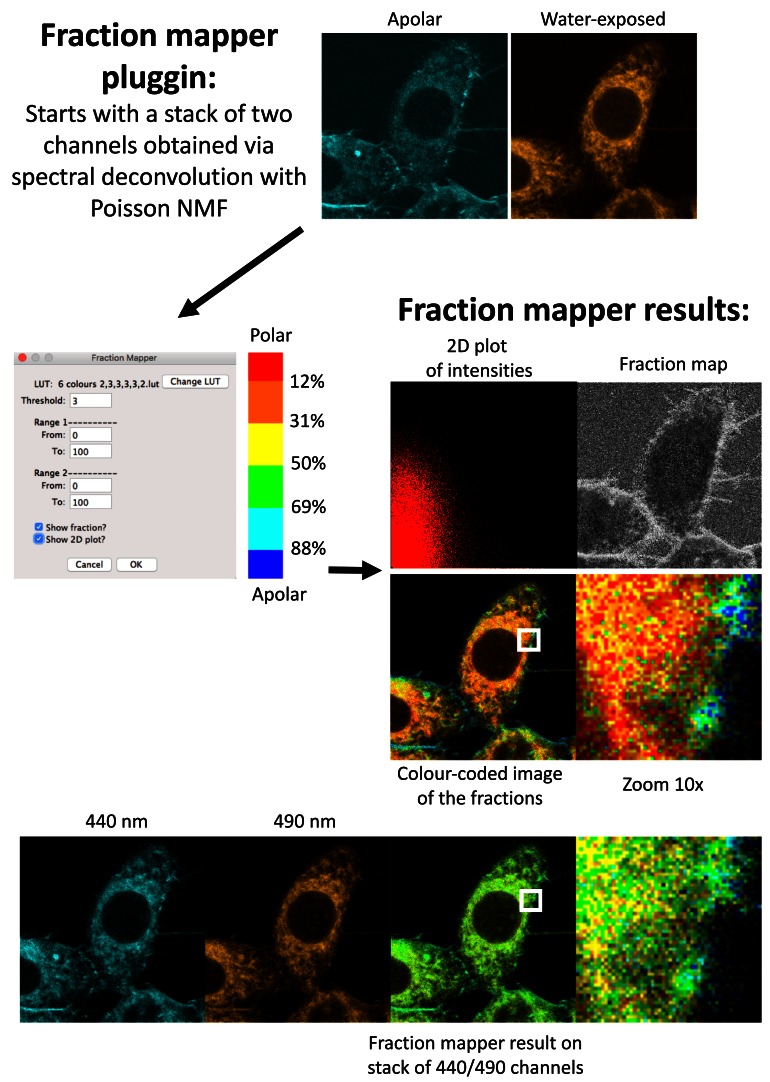
The Fraction Mapper plugin.Starting from a stack of two channels, Fraction Mapper calculates the fraction of the intensity in the first channel for every pixel (ch1/ch1+ch2), which can be obtained as a fraction map. A 2D plot of the intensities in each of the channels can also be generated. The plugin then colour-codes the numbers corresponding to the fraction according to a chosen LUT, and gives the pixels the light intensity of the sum of the two channels. The LUT used was based on six discrete colours from blue to red (LUT ‘6 colours 2,3,3,3,3,2’ available for download as
Supplementary File 2). Bottom row: Starting from the 440nm and 490 nm channels, classically used for calculating GP, the picture obtained is much less informative. Of note, GP values are closely related to fraction values we use in this study: the GP can be obtained simply by multiplying the fraction by two and subtracting 1. Owen
et al. have produced and published a ‘GP Calculator’ plugin (
Owen
et al., 2011) that provides very similar results to those obtained with Fraction Mapper, albeit by a more indirect approach. The 10× magnifications correspond to the 52×52 pixels regions indicated by white squares in the adjacent image; each pixel is 100×100 nm and the whole pictures cover 52×52 microns.